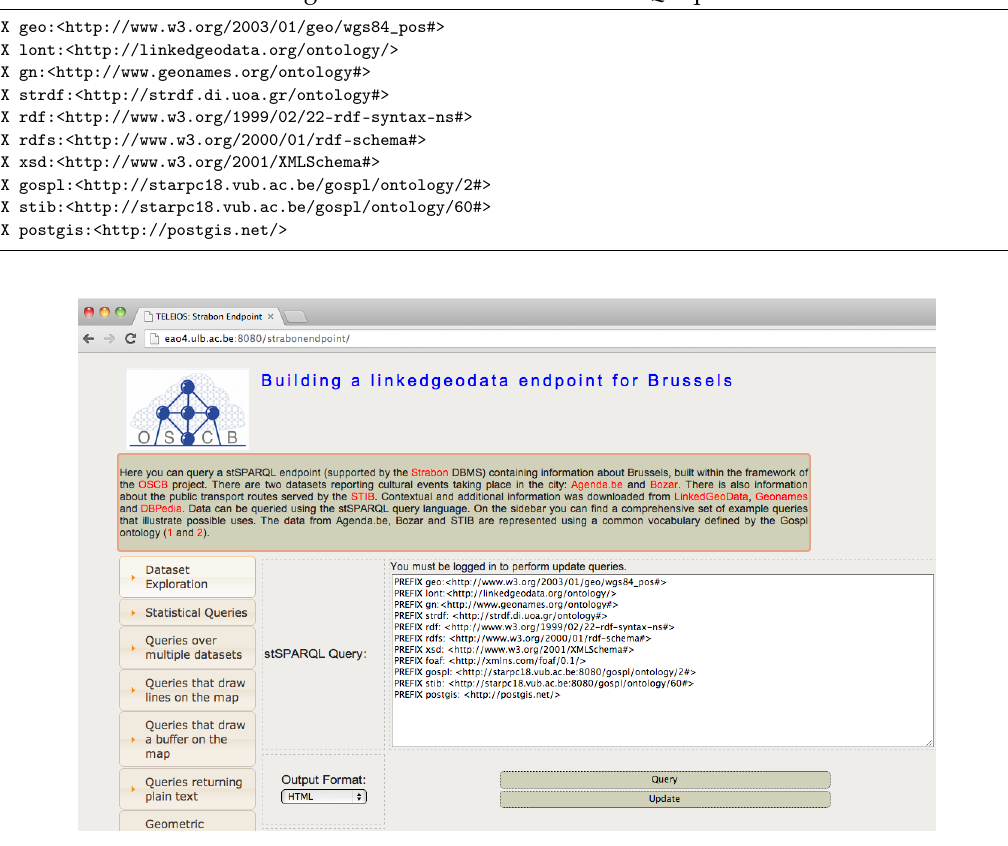
Figure 4. The stSPARQL endpoint’s